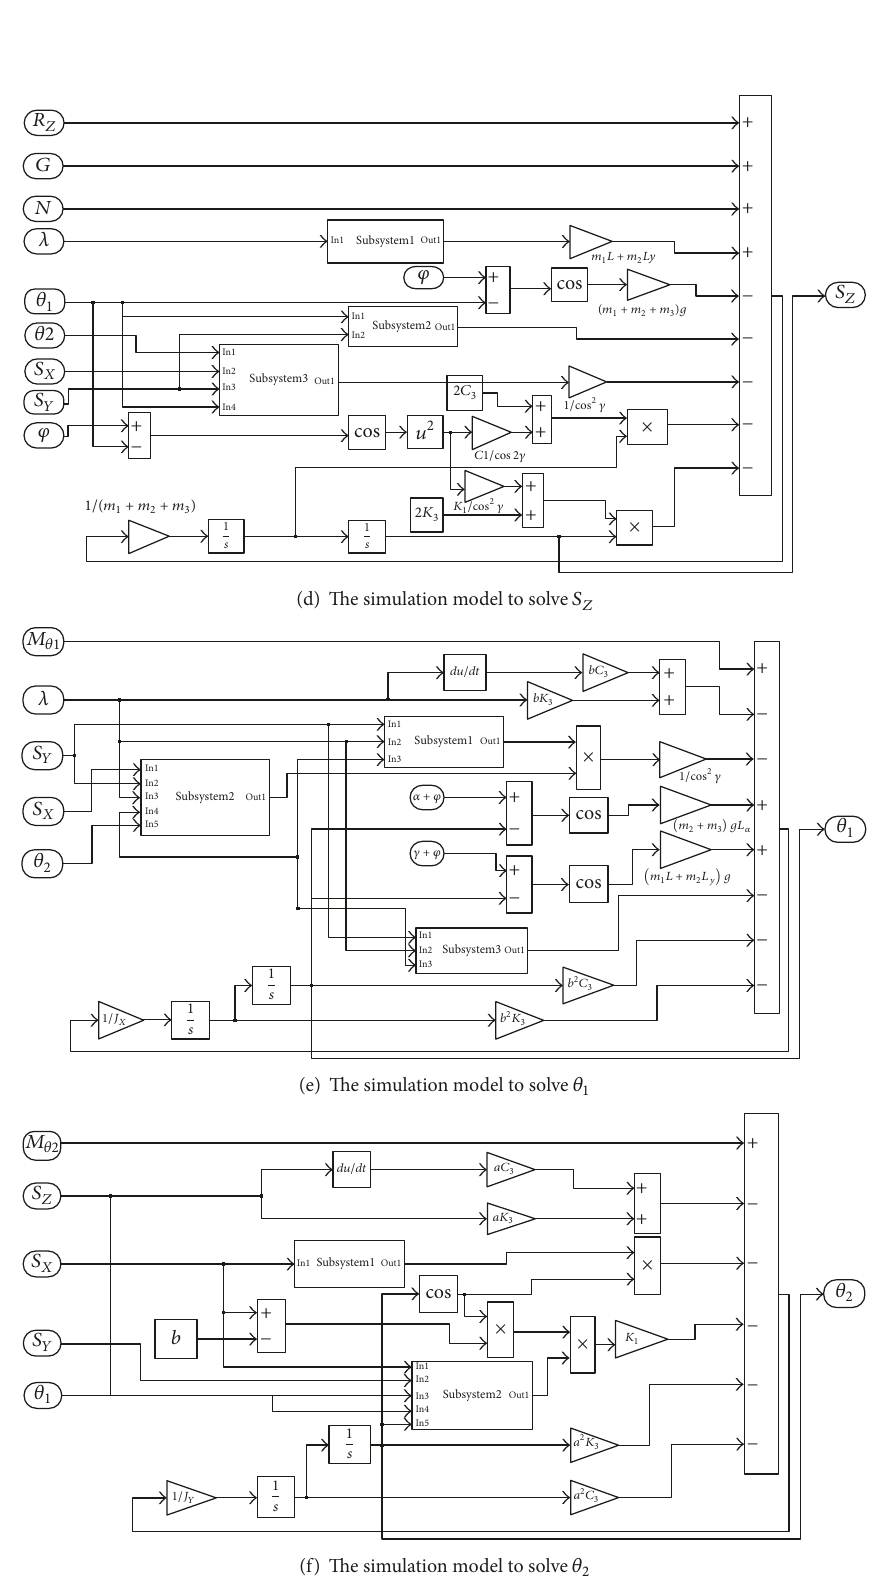
Figure 10: The simulation model to solve roadheader’s body pose during the horizontal cutting